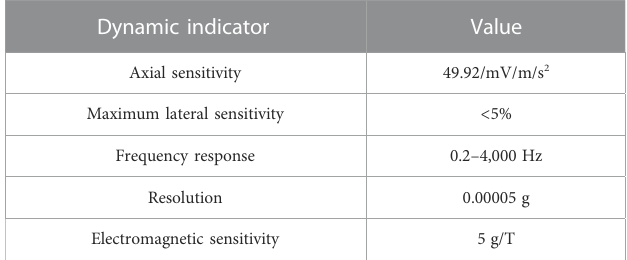
TABLE 2 Speci fi c parameters of the sensor (1A212E).